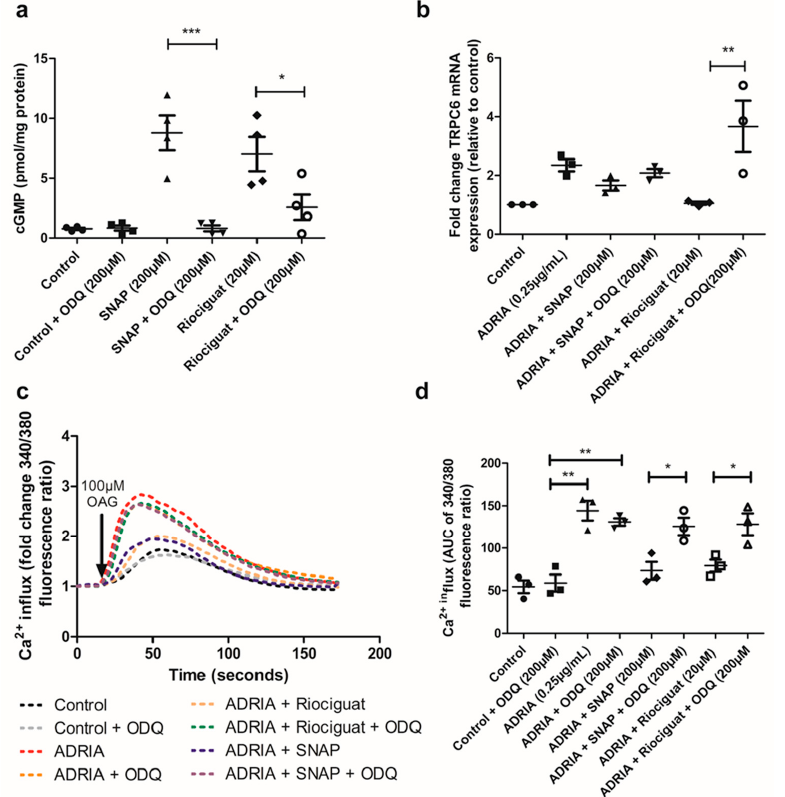
Figure 4. Inhibitory effects of Riociguat and SNAP are specifically mediated by sGC. ( a ) hPOD were stimulated with 20 µM Riociguat or 200 µM SNAP for 15 min in the absence or presence of 200 µM ODQ, and cGMP production was measured. ( b ) hPOD were treated for 24 h with 0.25 µg/mL Adriamycin to induce podocyte injury. Podocytes were simultaneously treated with either 20 µM Riociguat or 200 µM SNAP in the absence or presence of 200 µM ODQ, and TRPC6 mRNA expression was determined or ( c ) Ca 2+ dynamics were investigated using Fura-2 upon stimulation with 100 µM OAG. ( d ) Area under the curve of the fold change in the 340/380 ratio of Fura-2 AM was calculated to quantify Ca 2+ concentrations. * p < 0.05 ** p < 0.01 *** p < 0.001.